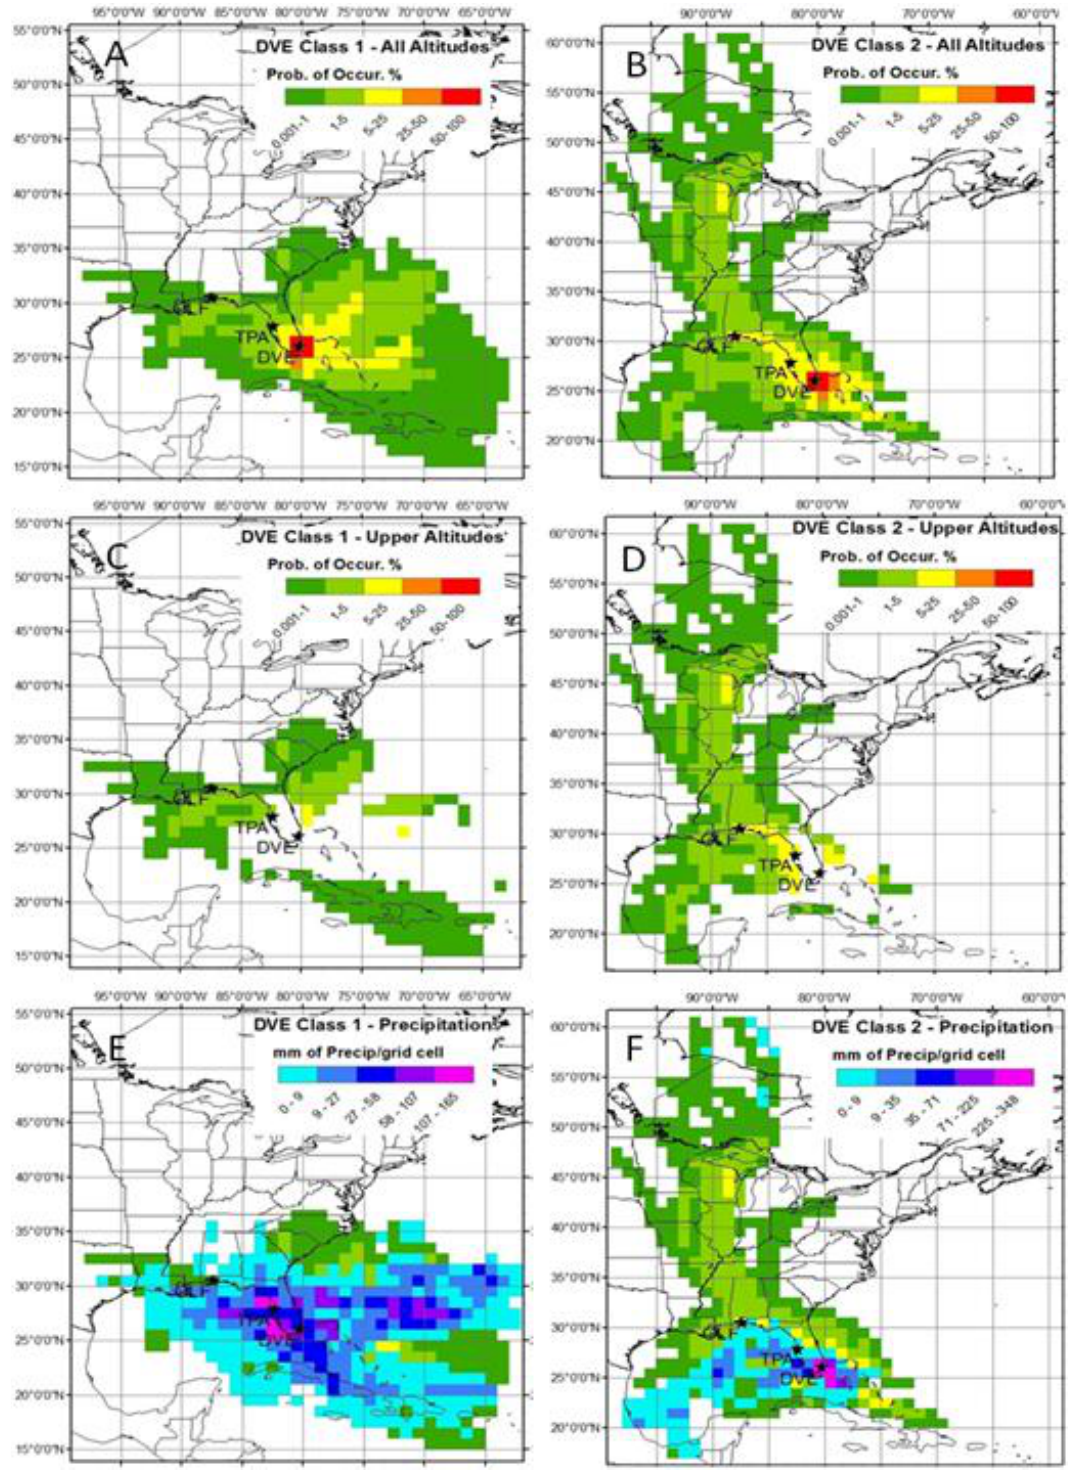
Fig. 5. Gridded frequency distributions of back trajectories for the five highest GOM concentration event days Classes 1 and 2 at the DVE site. (A) Horizontal location probabilities for Class 1 events. (B) Horizontal location probabilities for Class 2 events. (C) Same as A, but with color removed from grid cells with > 90% of trajectory points having altitudes below the modeled boundary layer. (D) Same as (C) except for Class 2 events. (E) and (F) Modeled precipitation distributions for Classes 1 and 2 events overlain on the horizontal location